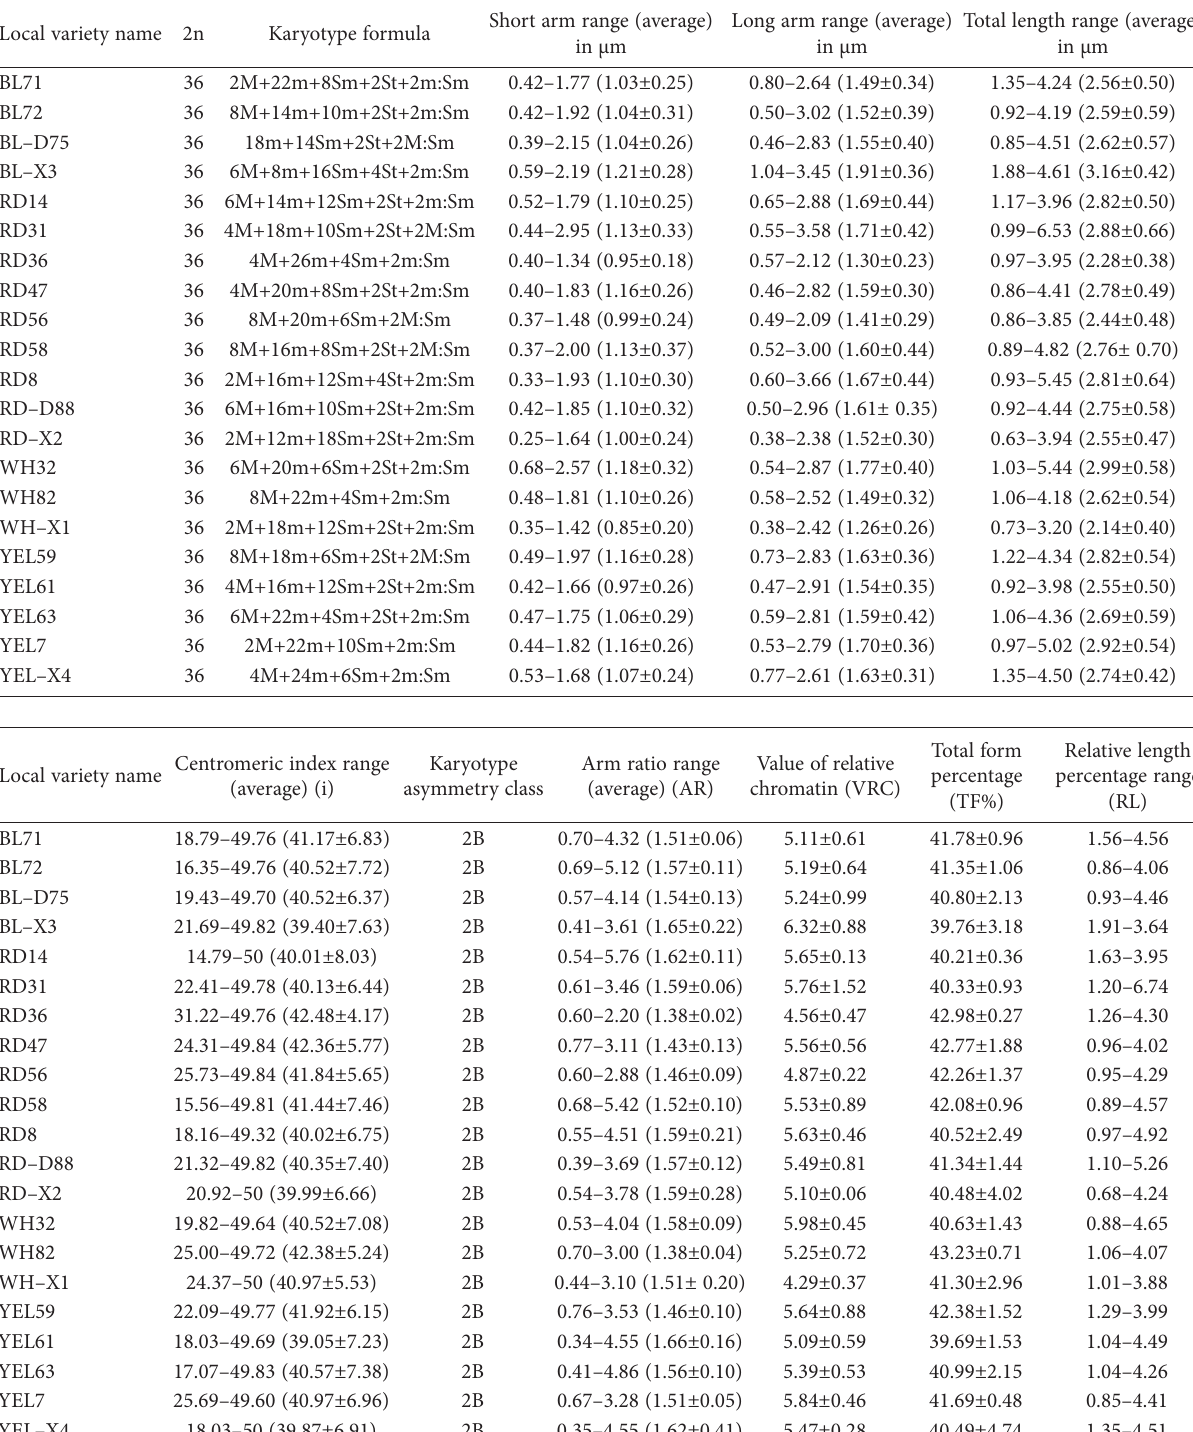
Table 1. Chromosome numbers, karyotype formulae, morphometric parameters and values of asymmetry indices studies in 21 Chenopo- dium quinoa